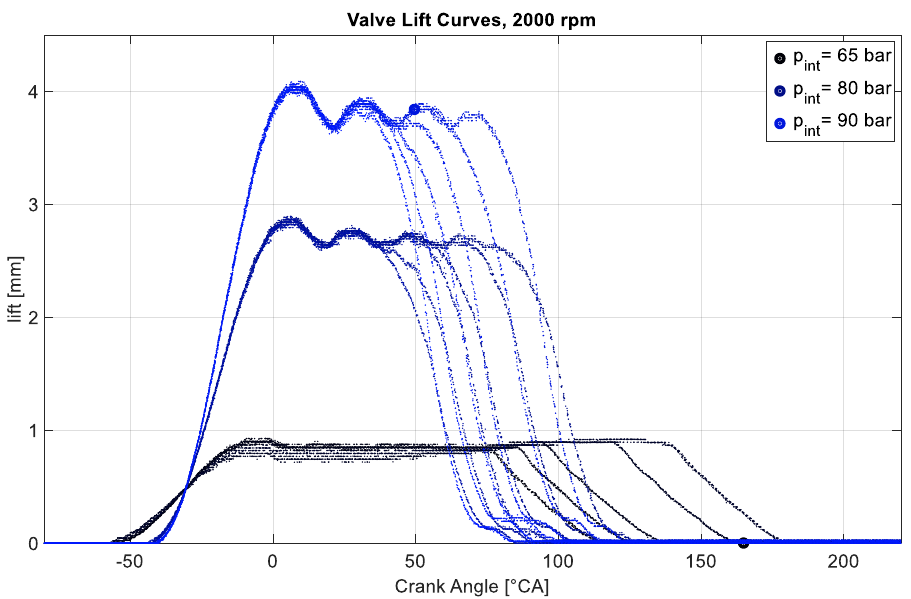
Figure 2. Scheme of the engine's and valve train's setup.